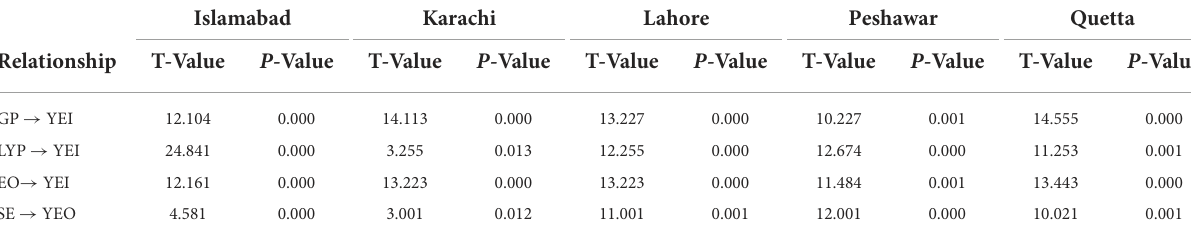
TABLE 8 Comparative analysis of the results.